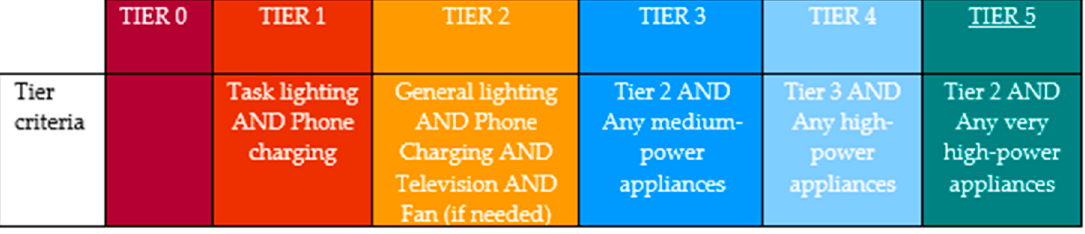
Figure 2. Multi-tier matrix for measuring access to household electricity services (source: [9]).